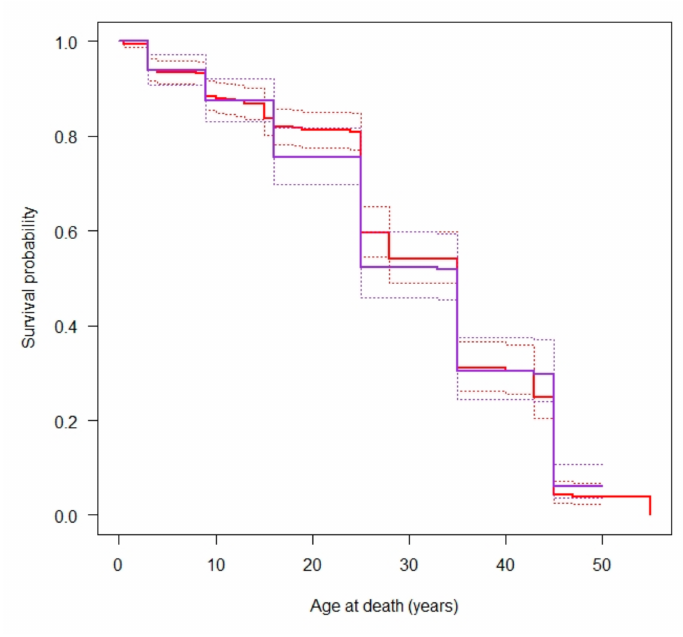
Figure 3. Survival curves for Imperial Roman (blue) and Medieval (red) populations with confidence bands (dashed